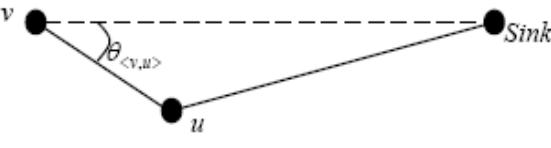
Figure 25. The illustration of the deflexion